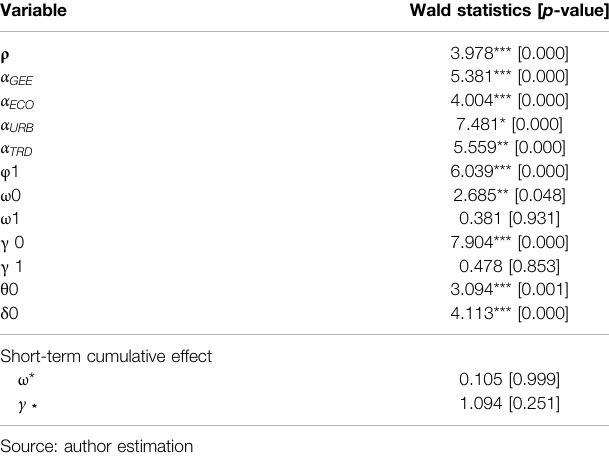
TABLE 5 | Results of the Wald Test for the constancy of parameters.